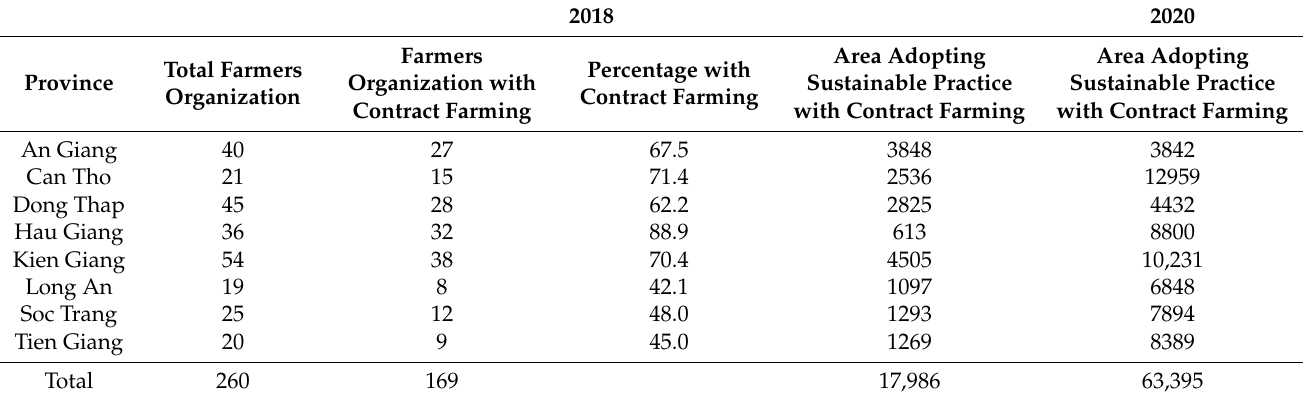
Table 3. Number of farmer organizations reached and those who engaged with contract farming with area coverage in the Mekong River Delta, 2018 and